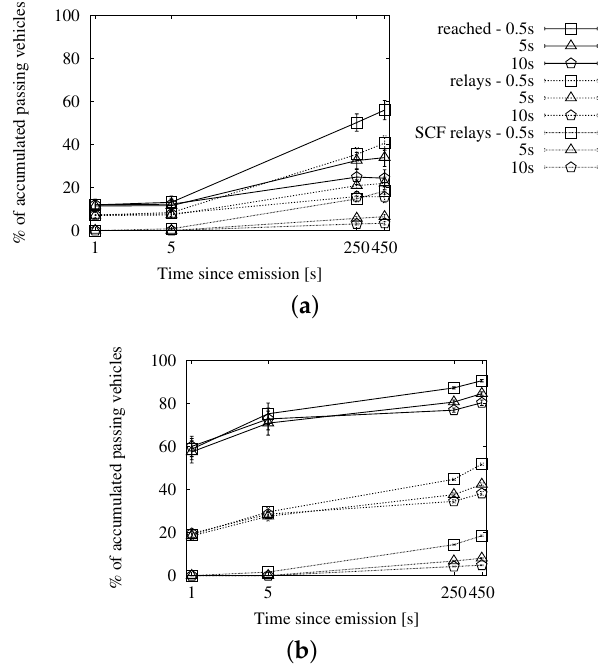
Figure 13. Involved vehicles with the map polling approach for store-carry-forward in the New York scenario: ( a ) roadway scheme, 25 vehicles/km 2 ; ( b ) roadway scheme, 100 vehicles/km 2 .